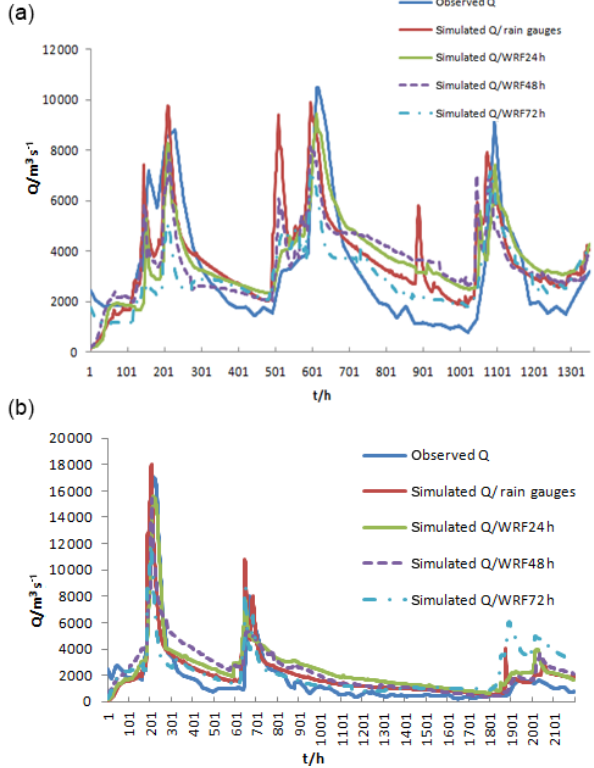
Figure 12. Simulated results with different lead times. (a) is the flood simulation results of flood event no. 2012; (b) is the flood simulation results of flood event no.